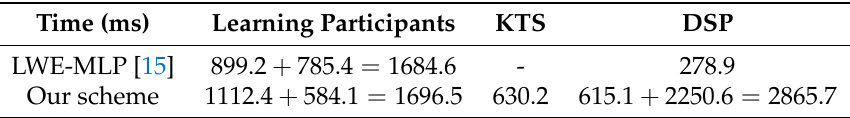
Table 6. Computational cost of parties